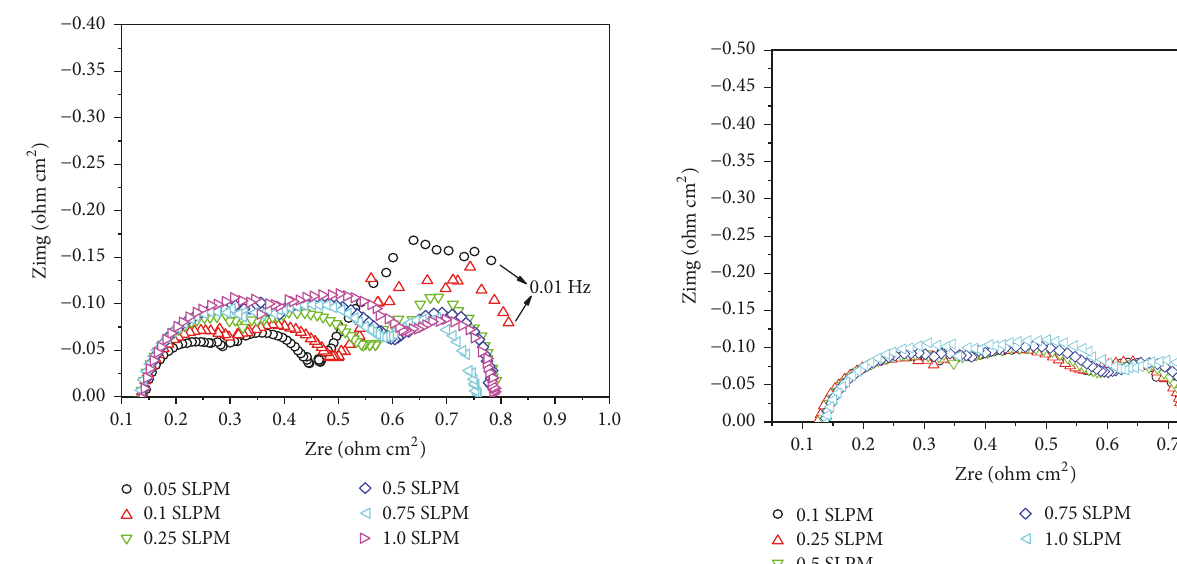
Figure 10: Impedance curves at different hydrogen flow rates at 750 ∘ C.